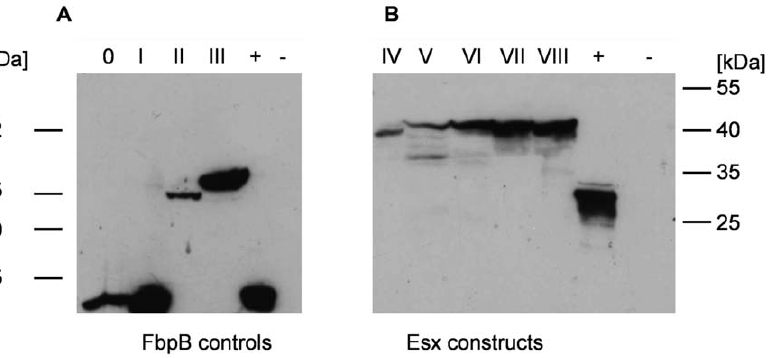
Figure 3. Protein expression of BlaTEM reporter constructs shown by Western blot analysis. Fusion-proteins expressed from the nine reporter vectors (pOLYG- blaTEM (0) and pI- blaTEM to pVIII- blaTEM ) were separated using SDS-PAGE (12.5% Tris-HCl gels) and blotted onto PVDF membrane. The membrane was incubated with an antibody against the b -lactamase TEM-1. (A) Protein expression of pOLYG- blaTEM (calculated mass 31.8 kDa) and the three Sec dependent FbpB b -lactamase fusion-constructs (pI- blaTEM , pII- blaTEM and pIII- blaTEM ). Their masses were calculated to be 31.5 kDa, 33.3 kDa, 61.5 kDa and 62.2 kDa, respectively. The apparent molecular weight corresponds to the mass of a mature protein without secretion signal sequence. (B) Expression of b -lactamase fusion products associated with one of the three ESX protein translocation systems in